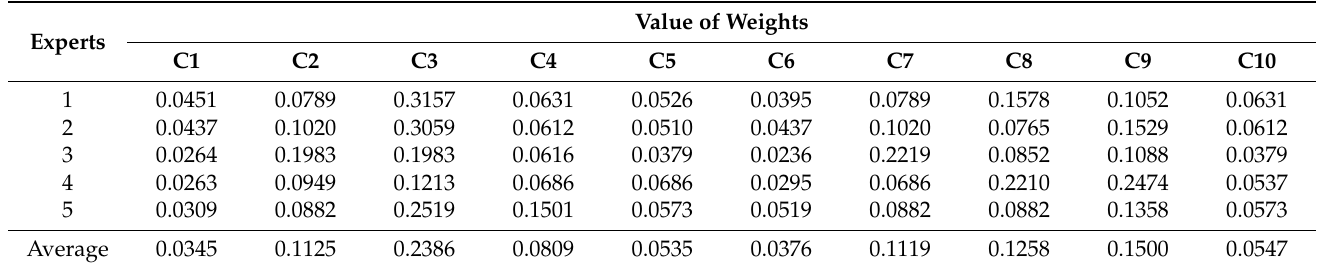
Table 9. The indicator weights determined by five experts based on the traditional